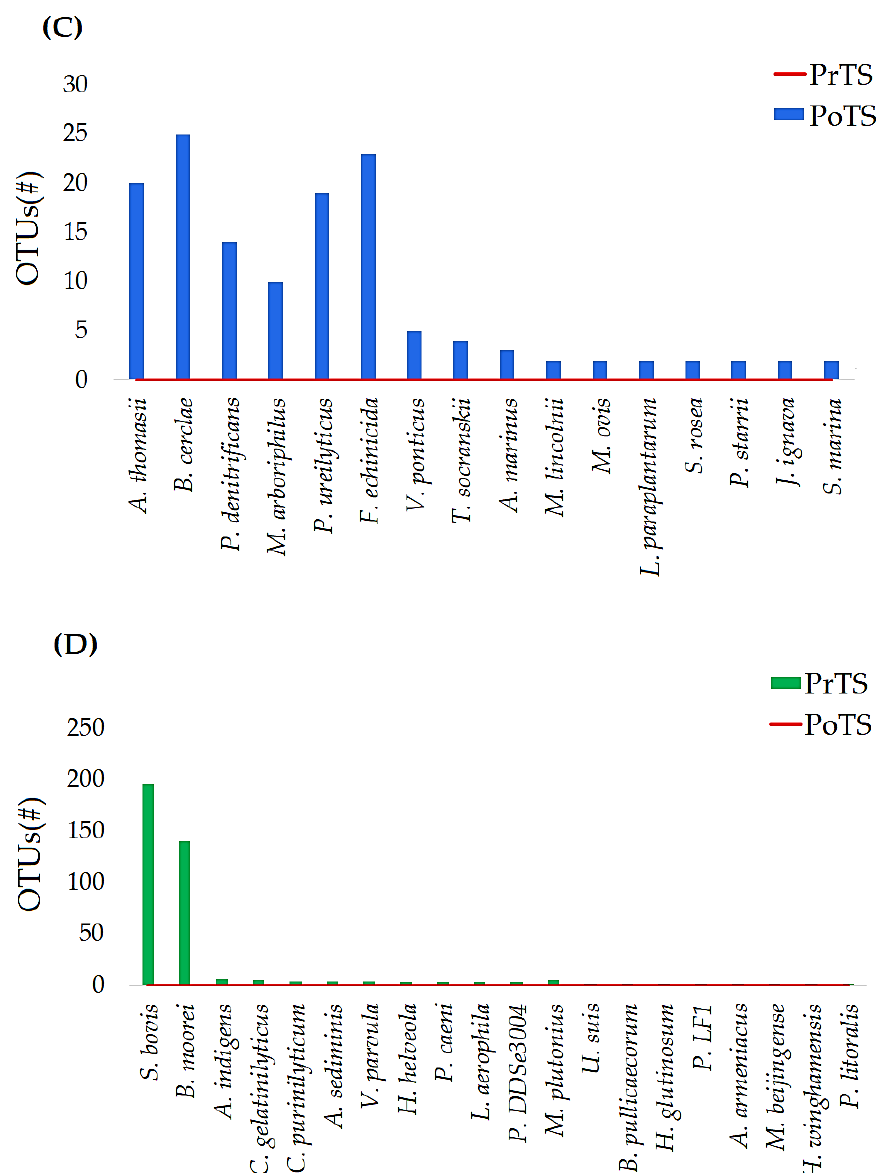
Figure 6. Comparison of the species-level relative frequency of the PrTS and PoTS of G1. The reduced ( A ), increased ( B ), newly evolved ( C ), and completely vanished ( D ) species in the control group after 42 days of study were reported.